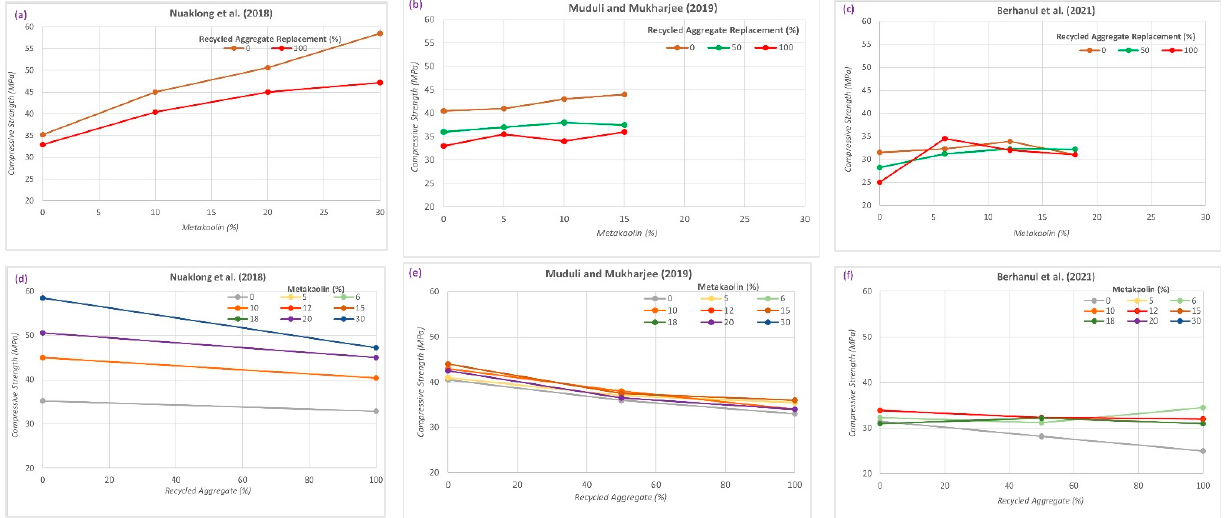
Figure 4. Relationship between the compressive strength of GRAC with different percentage contents of RA and MK. ( a ): compressive strength variation with different percentage of MK for 0% and 100% RA replacement [37]; ( b ): compressive strength variation with different percentage of MK for 0%, 50% and 100% RA replacement [38]; ( c ): compressive strength variation with different percentage of MK for 0%, 50% and 100% RA replacement [40]; ( d ): compressive strength relation with different percentage of RA for different percentage of MK [37];( e ): compressive strength relation with different percentage of RA for different percentage of MK [38]; ( f ): compressive strength relation with different percentage of RA for different percentage of MK [40].